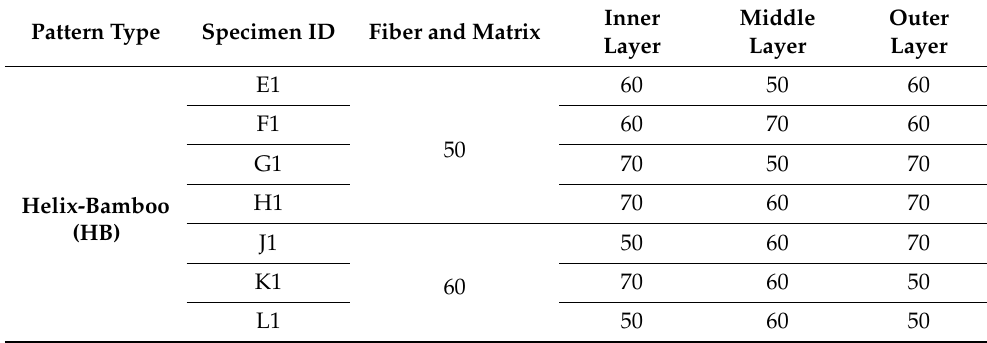
Figure 8. Helix-Bamboo (HB) pattern arrangement. In a cross-sectional view, the dimensions, helix- pitch, and orientation of each layer are reported. Table 4. Shore A hardness values were assigned for each layer of the Helix-Bamboo (HB) pattern. The range considered was from 50 (medium-soft) to 70 (hard-soft).